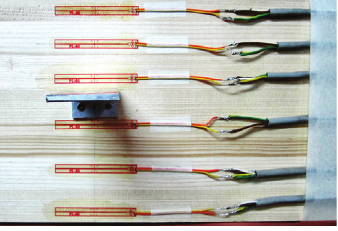
Fig. 3. Strain gauges